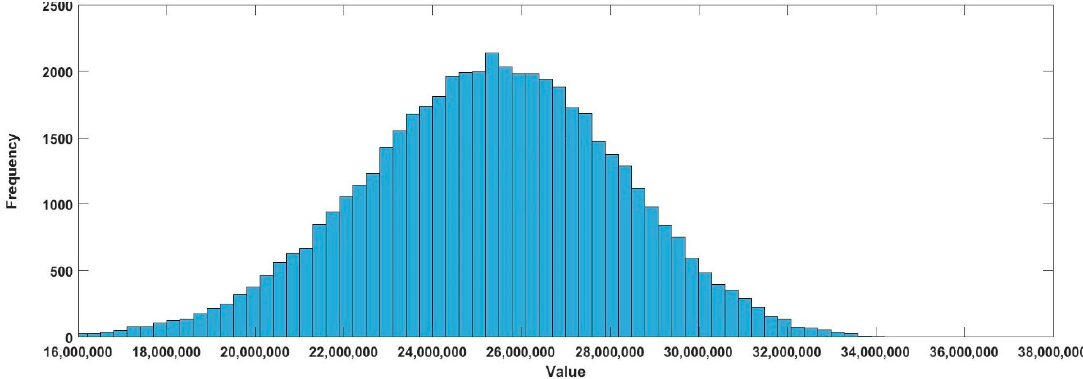
Figure 7. Histogram of the objective function at ε (cid:2904) = 1.1 for the technosociety/low value case with υ